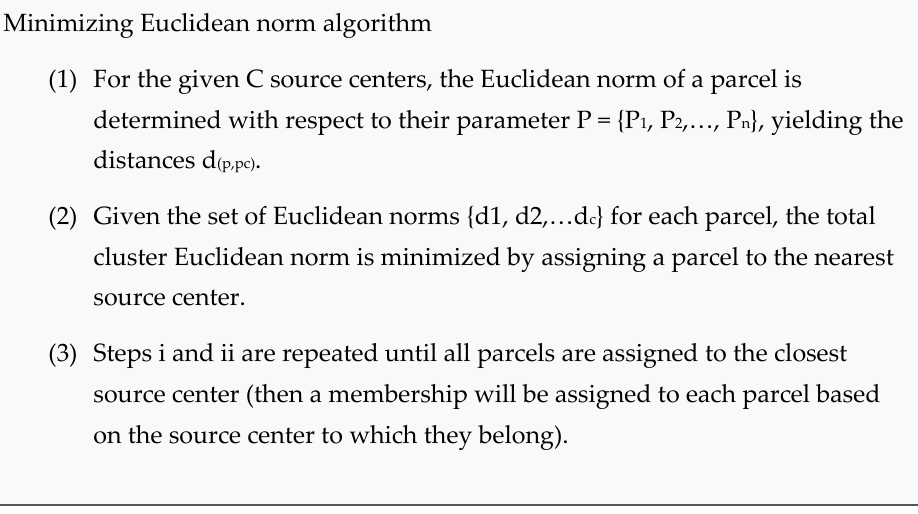
Figure 3. Basic minimizing Euclidean norm algorithm.